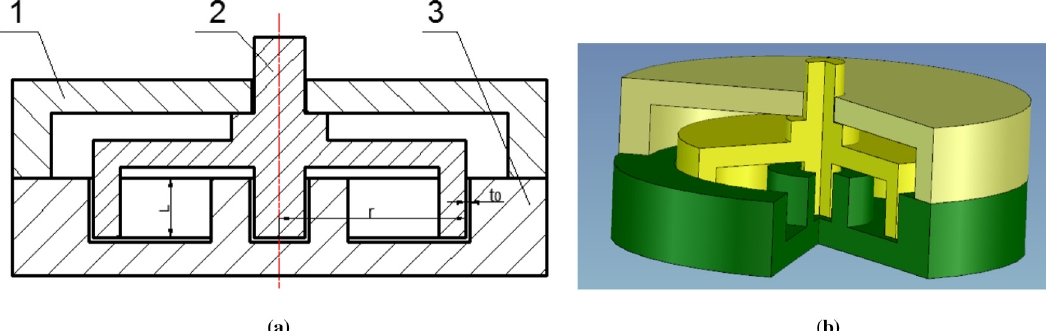
Fig. 1. An electromagnetic micro harmonic drive system. 1 Cover; 2 fl exible ring; 3 stator. (a) Section diagram (b) 3D model.